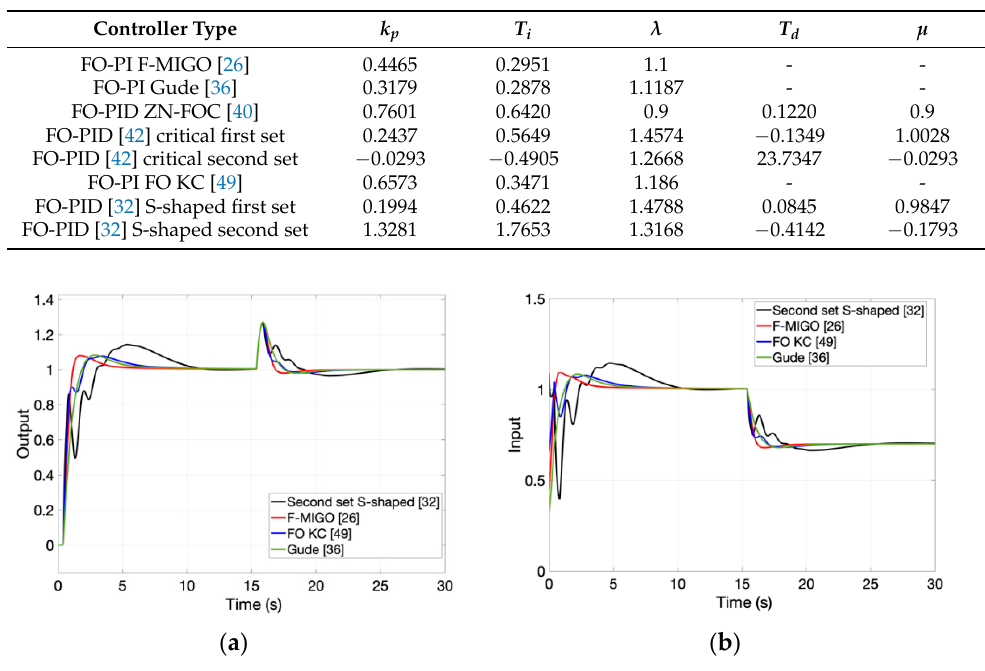
Table 8. FO-PID parameters computed for the integrative time-delay process.